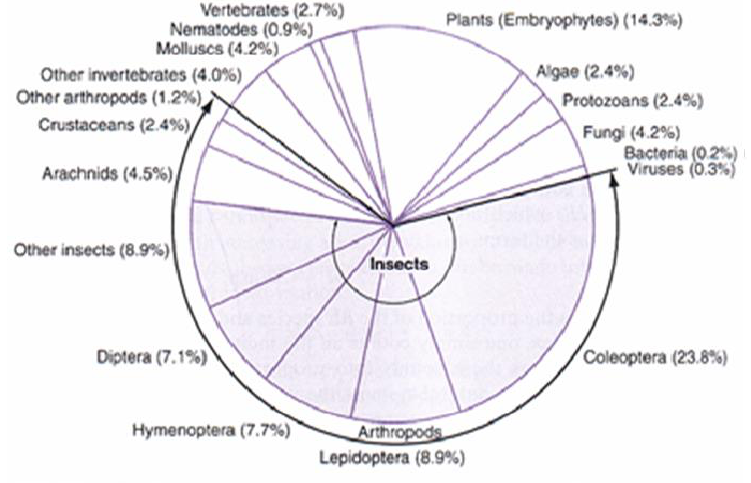
Figure 2: The Percent distribution of Known Species of living Organisms on